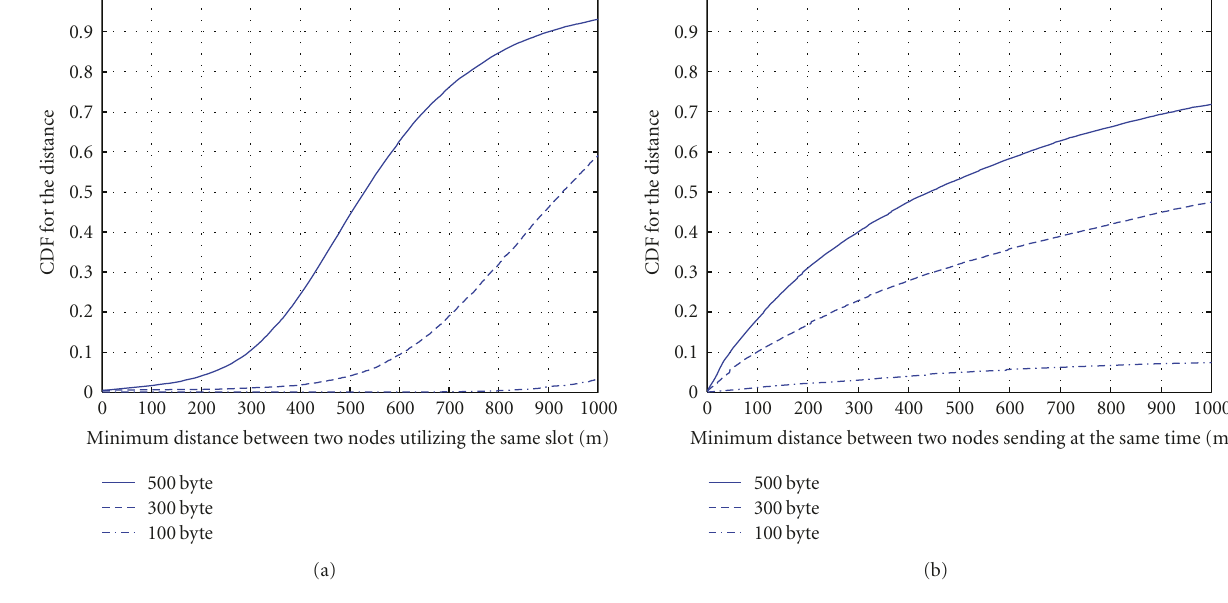
Figure 8: The CDF of the minimum distance between two nodes (a) utilizing the same time slot in STDMA and (b) sending at the same time in CSMA/CA, using 500 byte packets, heartbeat of 10 Hz, sensing range of 1000 m. Table 3: The transmission times for CSMA and STDMA, respectively, together with packet sizes and number of slots per frame in